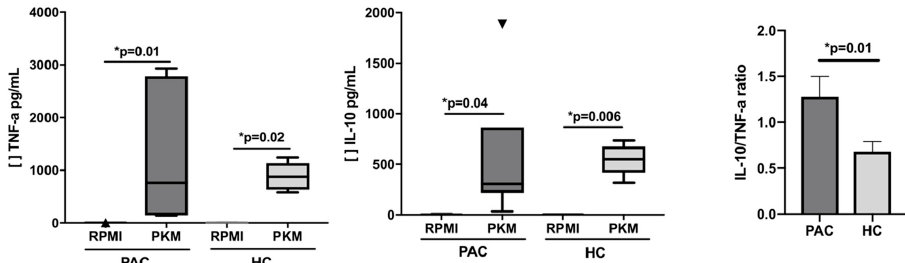
Figure 3. Tear cytokines in patients with perennial allergic conjunctivitis (PAC) and healthy controls (HC). The cytokines IL-10 and TNF were measured by cytometric bead arrays in tear samples from patients with PAC and HC. Significant differences were observed in IL-10 and TNF- α in PAC patients. Analysis of the IL-10/TNF- α ratio showed 2.8 more times tear IL-10 than tear TNF- α in HC. The ratio was calculated using the mean values for IL-10 and TNF- α . See Table 3 for additional determined cytokines. Statistical differences were considered when p < 0.05. [ ] Concentration of cytokine.